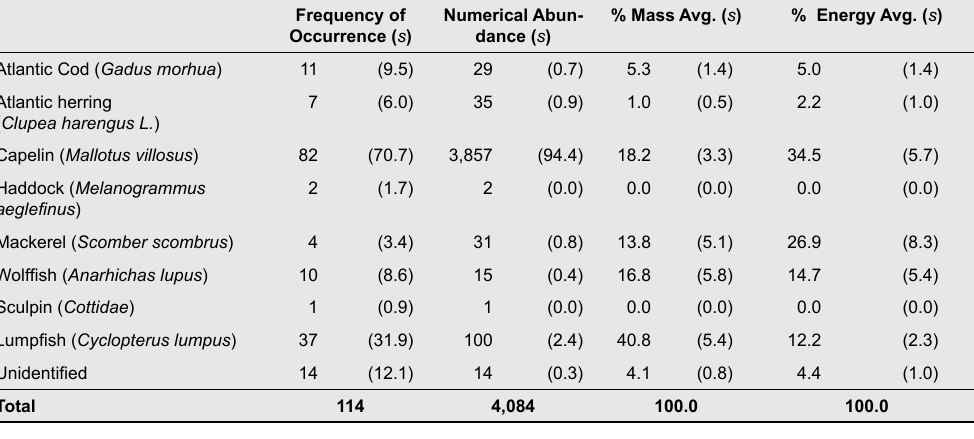
Table 3. Diet composition of 114 seals collected at Anticosti Island during May-July 1988. Fre- quency of occurrence and % frequency of occurrence in parentheses, numerical abundance with relative percent in parentheses, percent (%) mass and energy contribution to the diet with standard deviation in